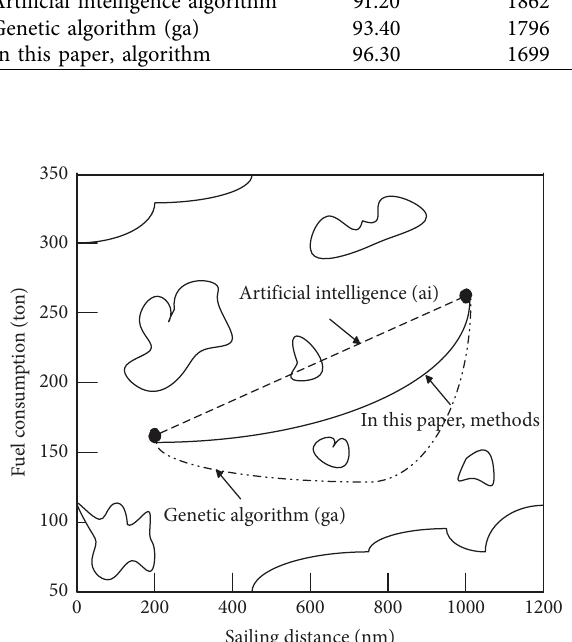
Figure 6: Fuel consumption for distance 1200nm.